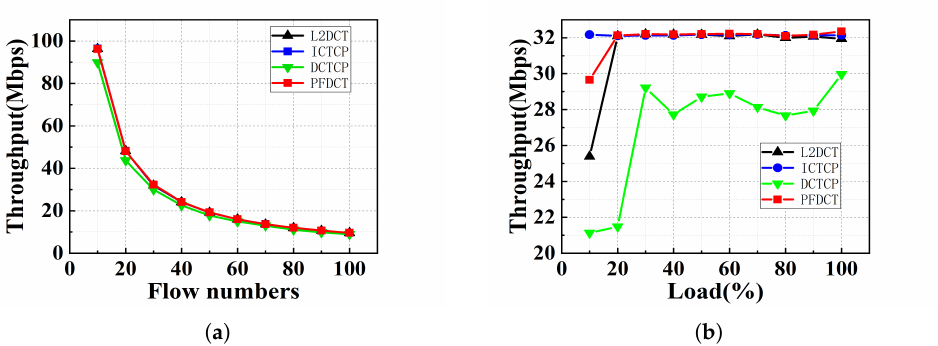
Figure 6. Throughput comparison of multiple schemes in simple-scale topology. ( a ) Throughput comparison with varying flow numbers. ( b ) Throughput comparison with varying